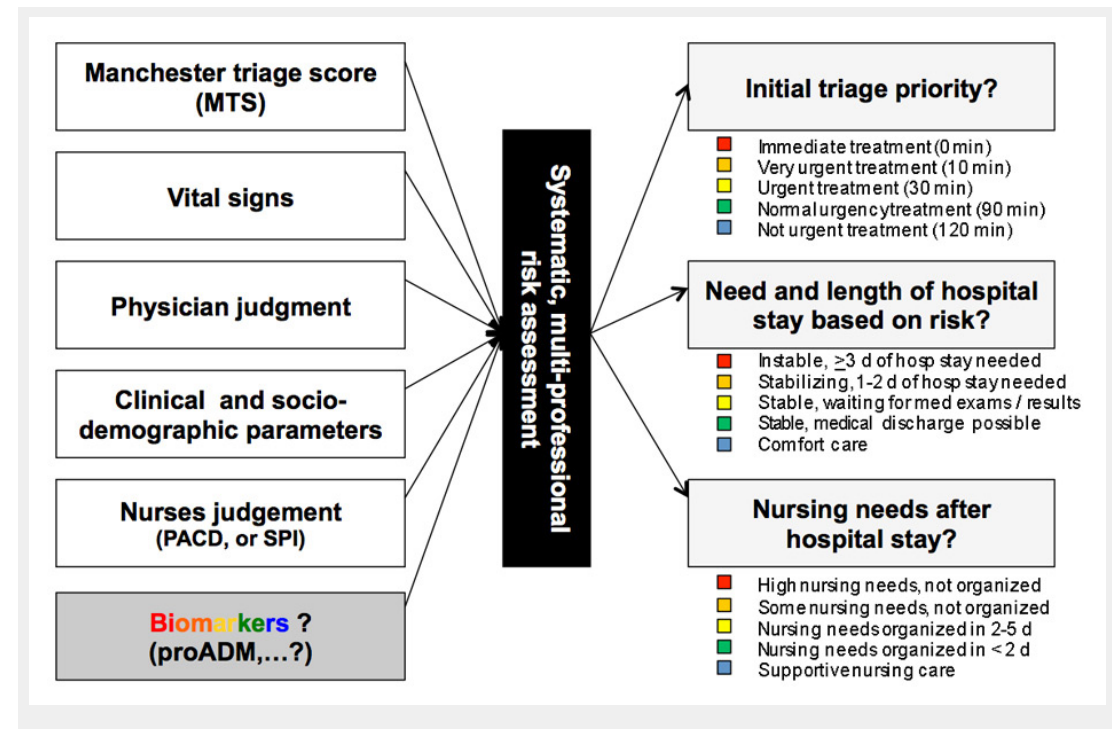
Systemic multiprofessional risk assessment for improve patient management adapted from [261]. ProADM =